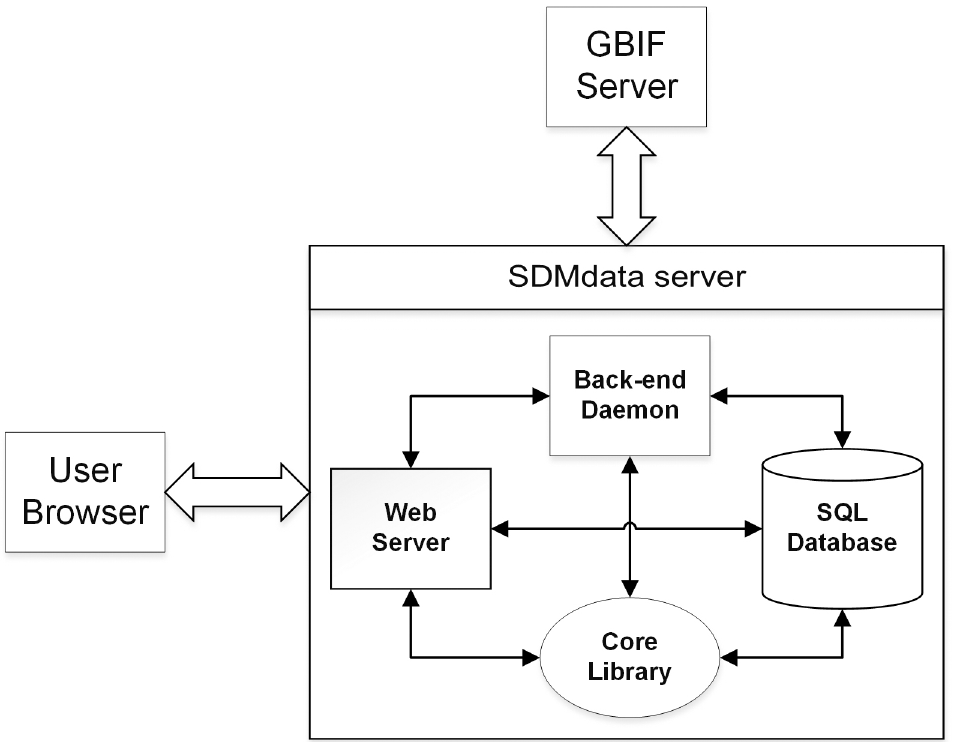
Fig 1. Structure of